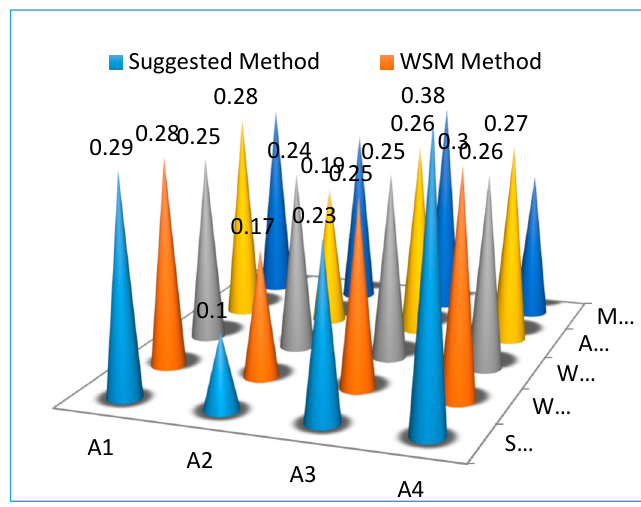
Table 26. The normalized weighted values of judgments matrix using the multi-objective optimization based on simple ratio analysis (MOORA).